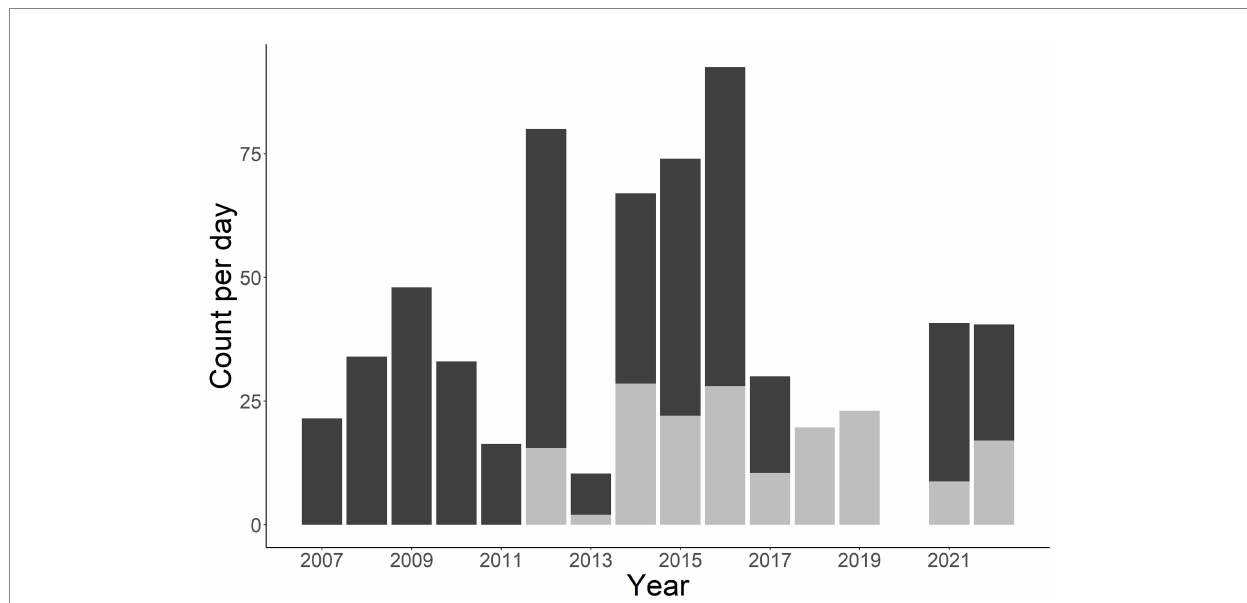
FIGURE 3 Stacked bar chart of total number of Sicklefin Redhorse Moxostoma sp. collected in the Little Tennessee River (dark grey) and Tuckasegee River (light grey). Sampling was not conducted in the Tuckasegee River prior to 2012 or the Little Tennessee River in 2018 and